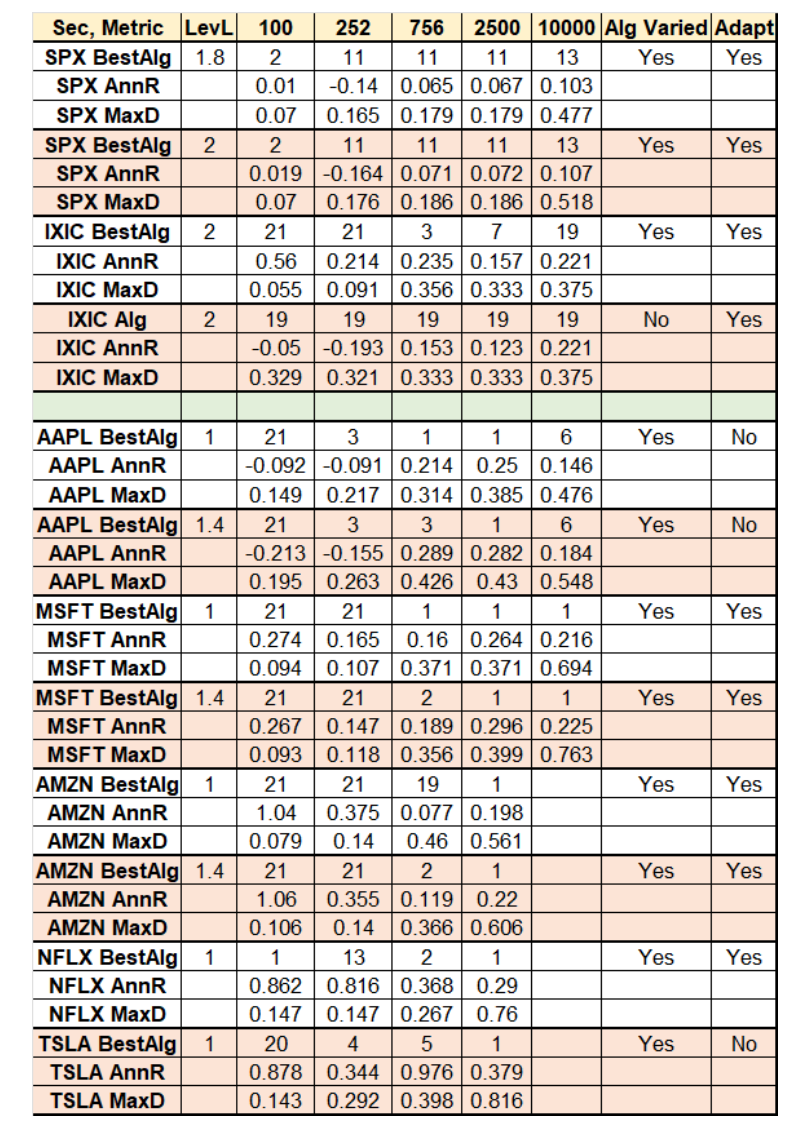
Figure 13. Tabular representation of key findings of this paper, showing performance over a range of trading time periods: approximately 5 months, 1 year, 3 years, 10 years, and 40 years, all ending 31 December 2022, for a various of financial instruments, including indices and individual